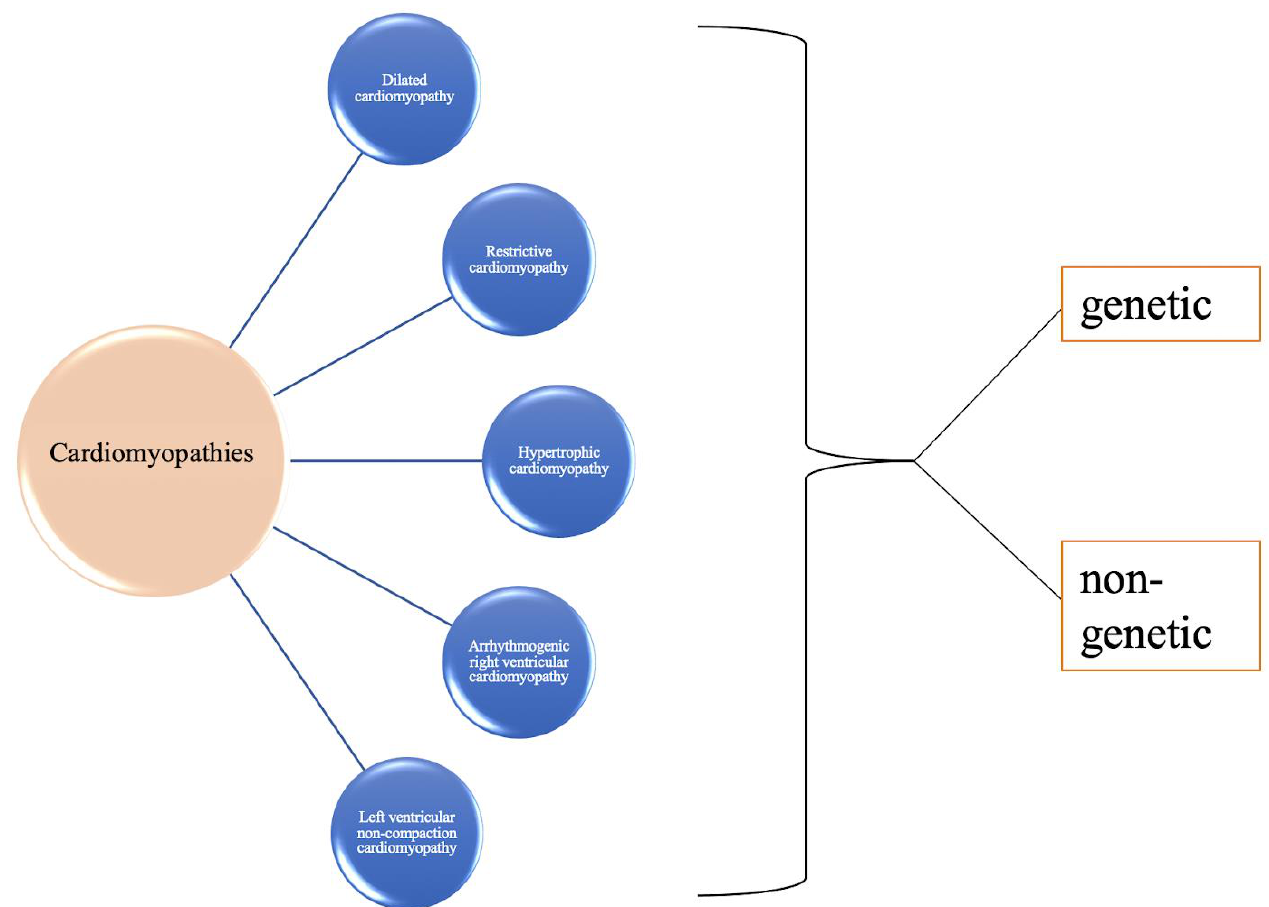
Figure 1. Cardiomyopathies are classified into five groups. All groups could be caused by genetic and nongenetic factors. Adopted from Czepluch et al. [76].